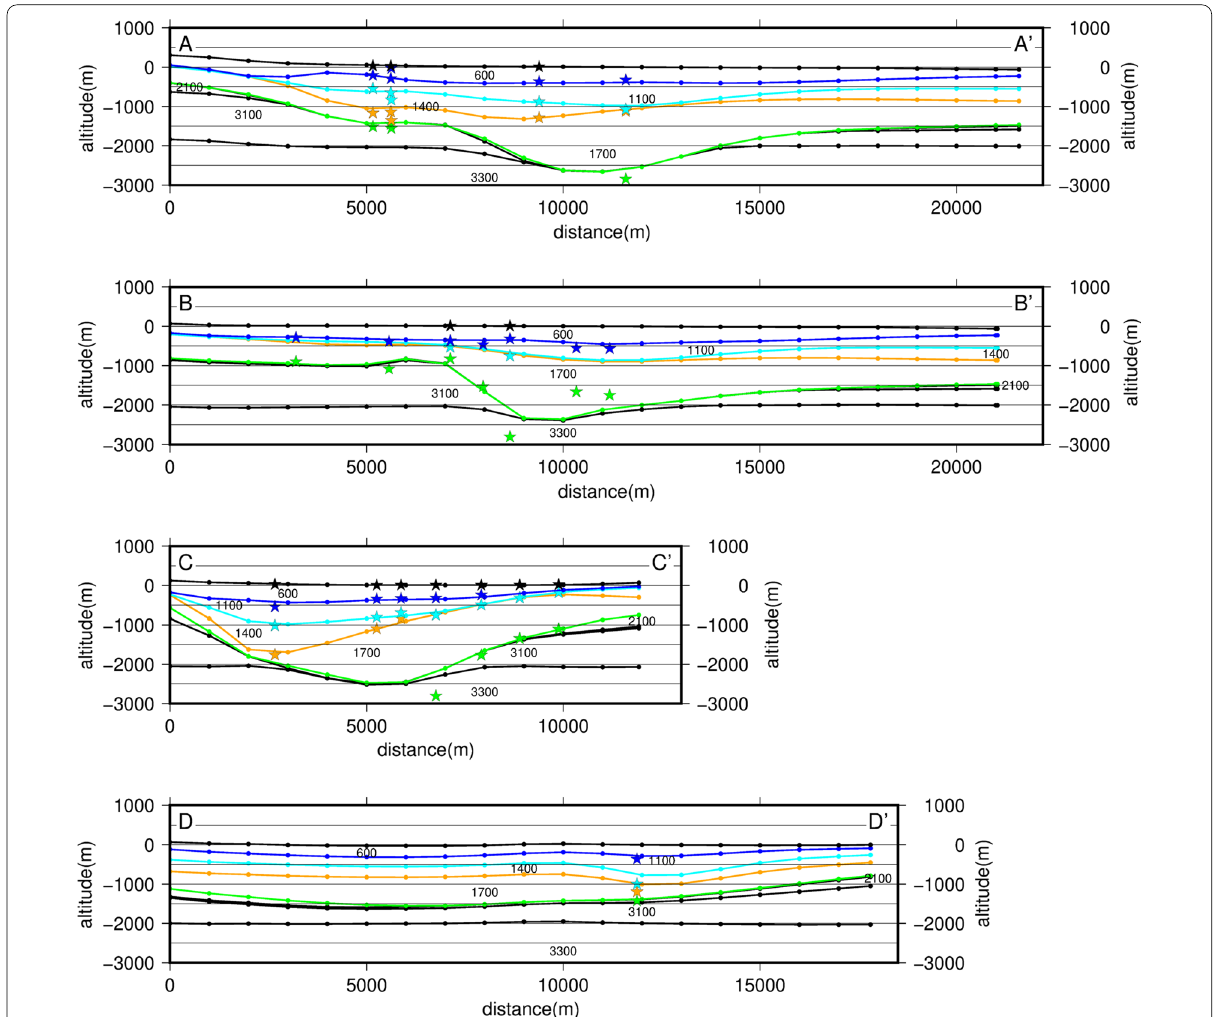
Fig. 8 Vertical cross sections of the velocity structure model developed in this study. The locations of the profiles are displayed on the map in Fig. 5. The black line represents the ground surface, and the black stars indicate the locations of control points on the ground surface. Each color line represents the bottom depth of each velocity layer in our estimated three-dimensional velocity model, and each color star indicates the bottom depth of each velocity layer of input data given at each control point (dark blue: V S V S 1.7 km/s). The number corresponds to the S-wave velocity of each layer. The small dots are placed at every 1 km along the profile line as a kind = of tick